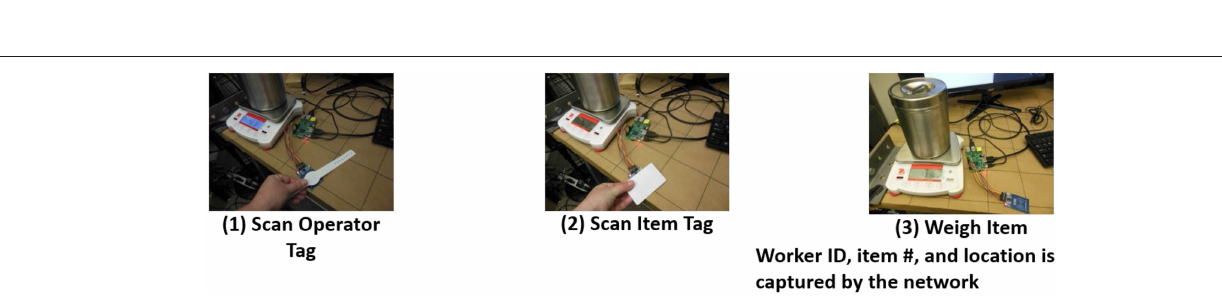
FIGURE 2 | The layout of the prototype network of components used for the next generation of smart nuclear infrastructure.